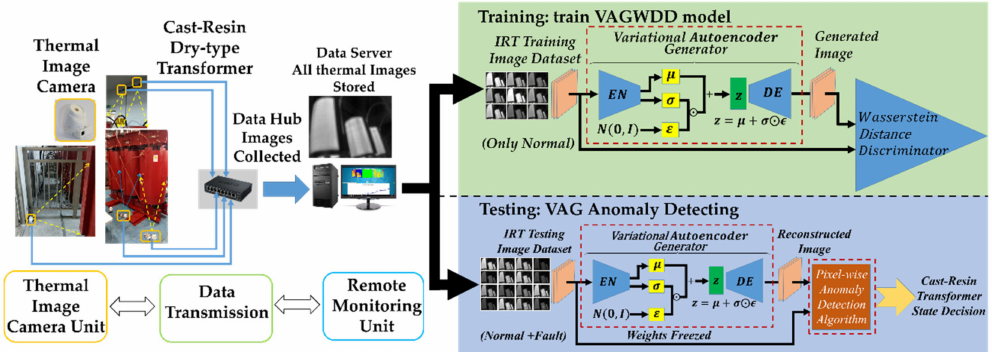
Figure 1. Flowchart of the proposed cast-resin transformer anomaly detection system based on the Variational Autoencoder Generator and the Wasserstein Distance Discriminator (VAGWDD)